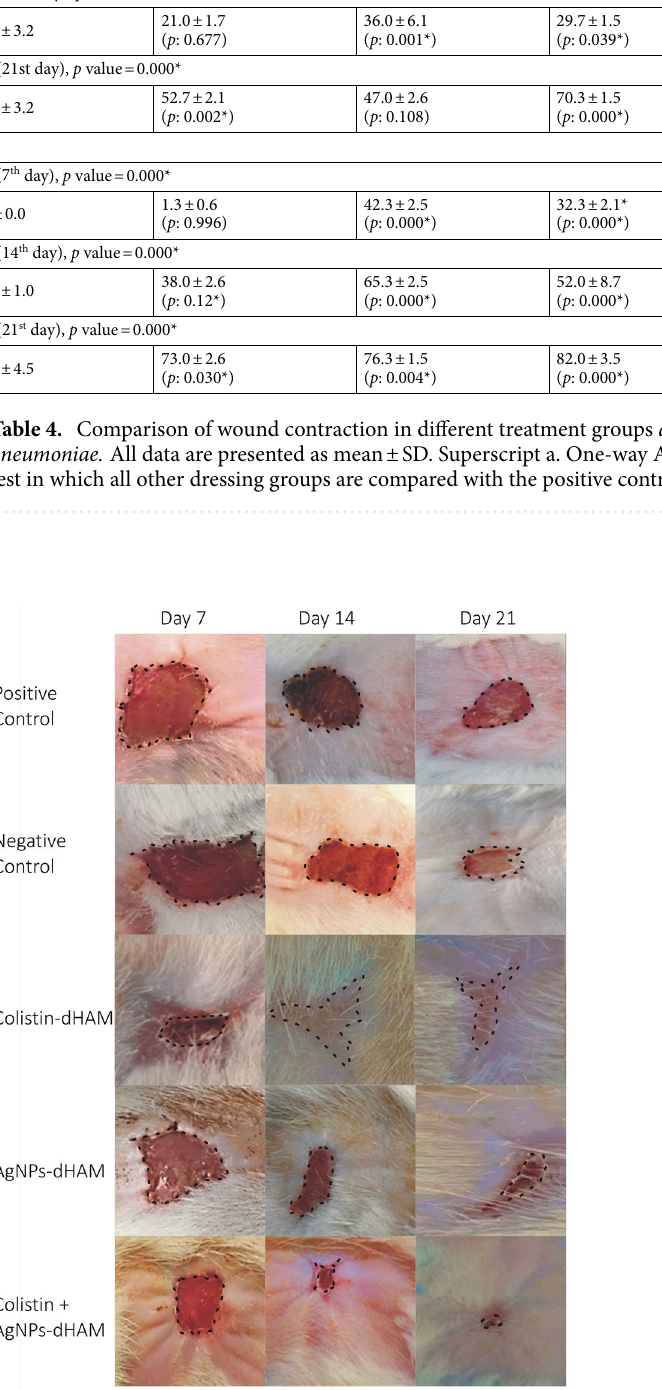
Figure 1. Wound healing in different dressing groups of rats against P. aeruginosa on days 7, 14 &